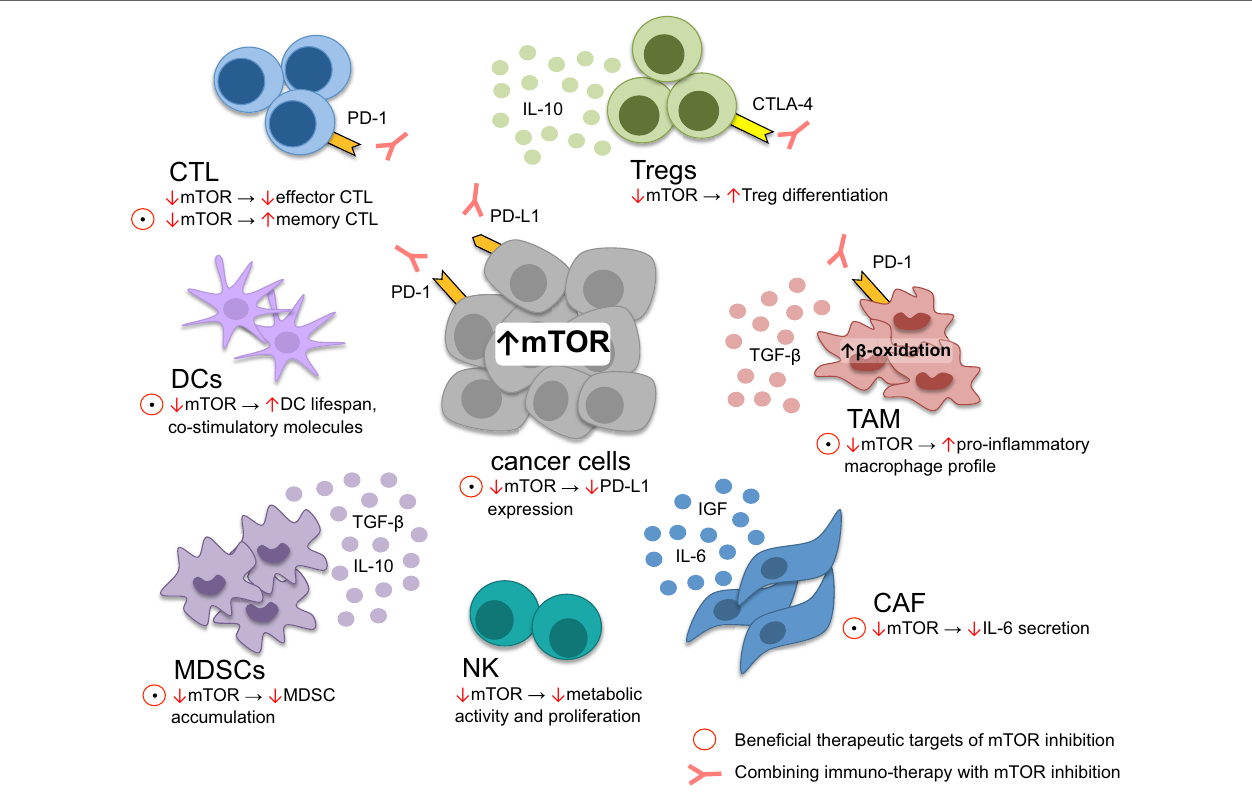
FigURe 2 | Tumor microenvironment modulation through mTOR. mTOR inhibition induces memory cytotoxic CD8 + T lymphocytes (CTL) formation while reducing effector CTL function, critical for cellular antitumor response. In dendritic cells, lifespan and the expression of costimulatory molecules is increased upon mTOR suppression, leading to improved foreign-antigen recognition. On the other hand, metabolic NK-cell function, essential for antitumor response, is diminished upon mTOR inhibition. Myeloid derived stem cells (MDSC), regulatory T cells (Tregs), tumor-associated macrophages (TAM), and cancer-associated fibroblasts (CAF) contribute to tumor immune-evasion and tumor growth. The immune-suppressive environment generated through MDSC is limited through mTOR blockage by restraining MDSC accumulation. Similarly, anti-inflammatory TAM may be skewed toward a more pro-inflammatory profile upon mTOR inhibition. CAF secrete various cytokines promoting tumor growth and therapy resistance, counteracted by mTOR blockage. In contrast, Tregs are preferentially differentiated upon mTOR downregulation. Within the majority of cancer cells, the PI3K–mTOR–AKT pathway is upregulated, driving PD-L1 expression maintaining an immune-suppressive state within the tumor microenvironment: a process that may be interrupted through mTOR inhibition. However, not all therapeutic targets of mTOR inhibition seem to be beneficial, such as reducing effector CTL function and T-Reg differentiation. Accordingly, rationale exists to combine anti-PD-1/PD-L1 or anti-CTLA-4 and mTOR inhibitors, alleviating reduced CTL effector function and Treg